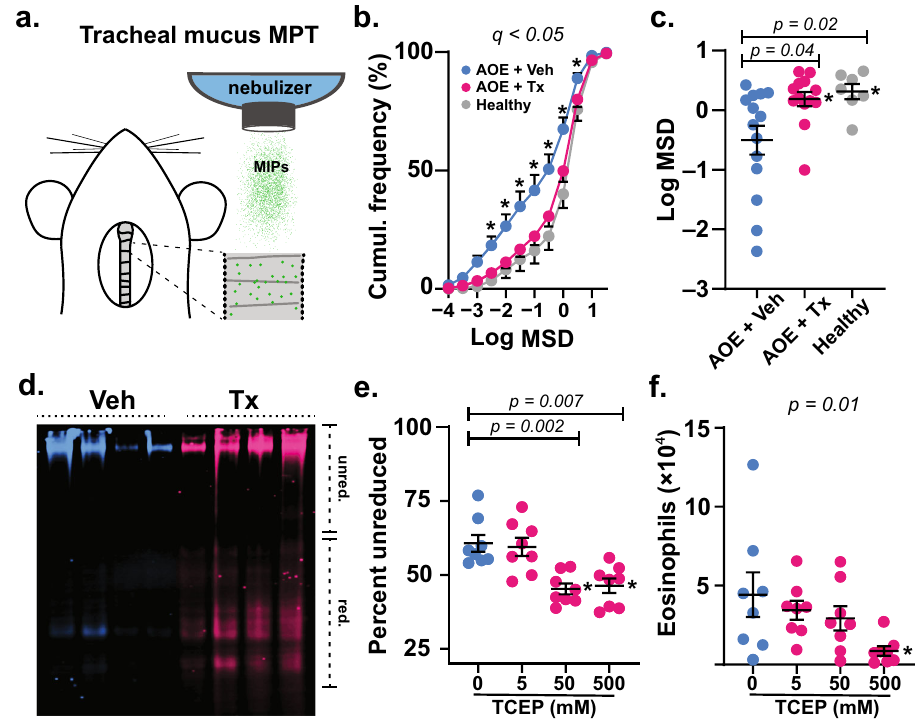
Fig. 2 Mucolytic treatment improves mucus function in allergic mouse airways. a Mucus was probed in tracheal preparations ex vivo using 100nm